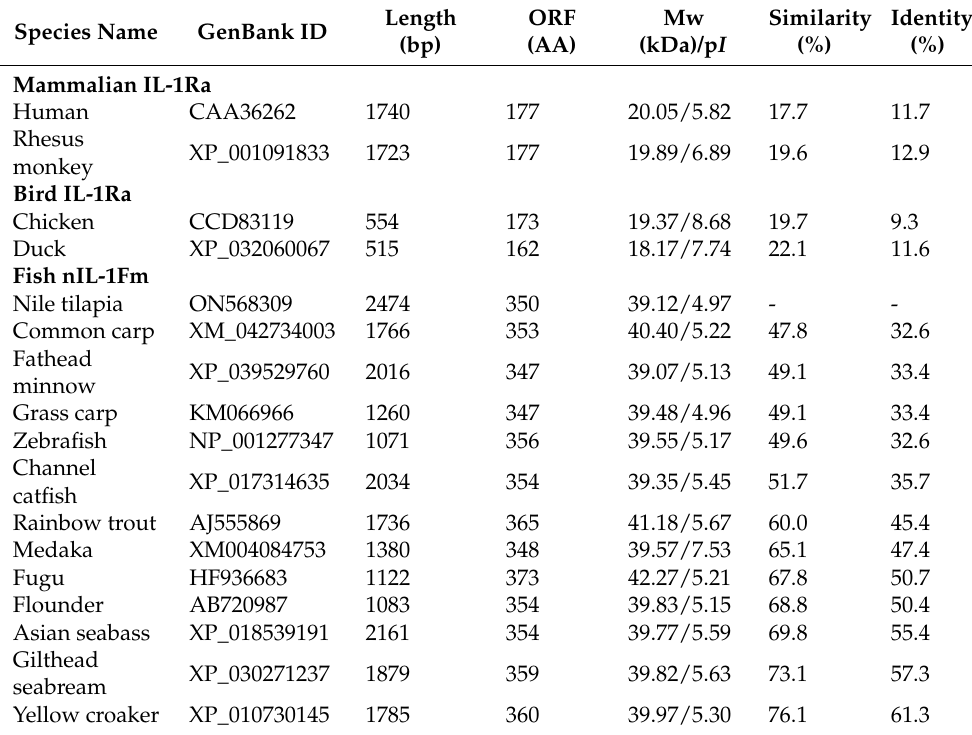
Table 2. The species name, the GenBank ID, the length and mature peptides and their identity with Nile tilapia